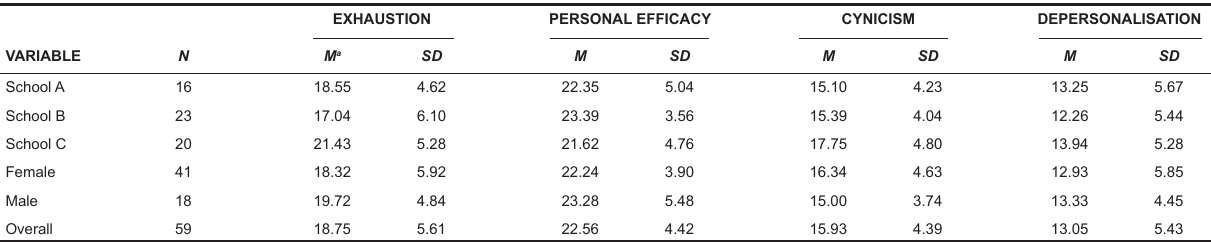
TABLE 2 Mean scores and standard deviations on sub-dimensions of the